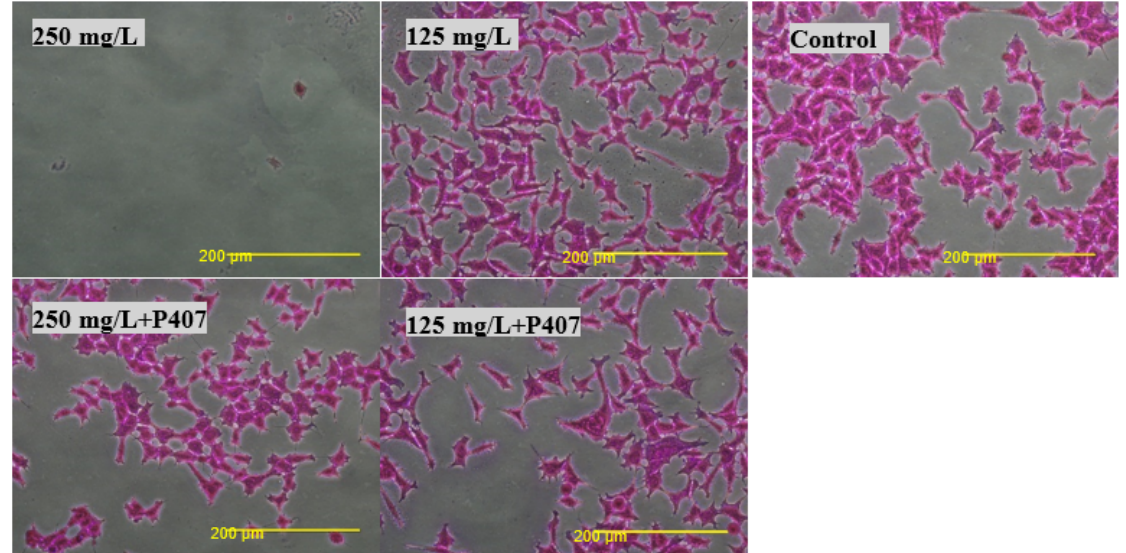
Figure 10. Micrographs of HEK293 cells treated with Thymol and Thymol-P407 at a concentration of 125 and 250 mg/L for two hours at 37 °C and stained with SRB (×200).